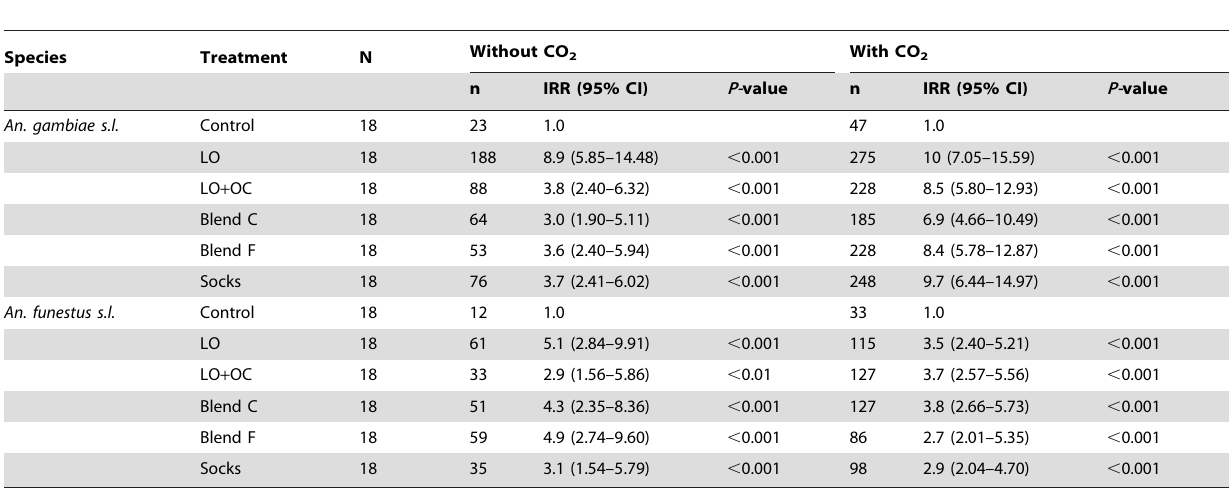
Table 2. Total anopheline trap captures with plant and animal odor compounds and worn socks in the presence or absence of carbon dioxide using MM-X traps.